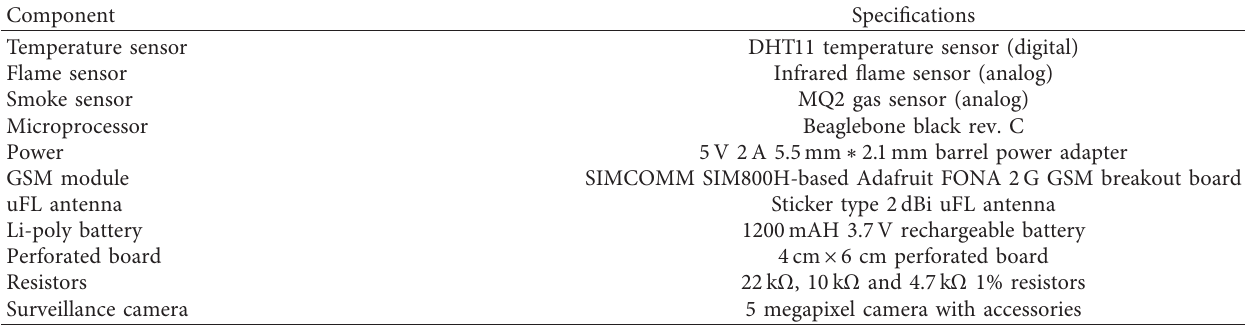
Table 4: Hardware